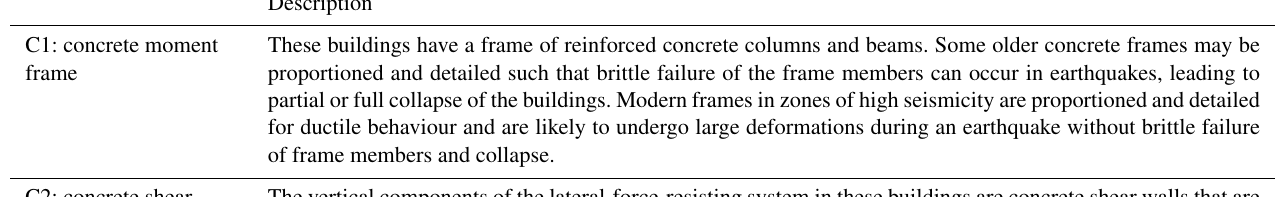
Table 2. Description of the HAZUS MH4 categories involved in the INSPIRE index (modified after Kircher et al., 2006).